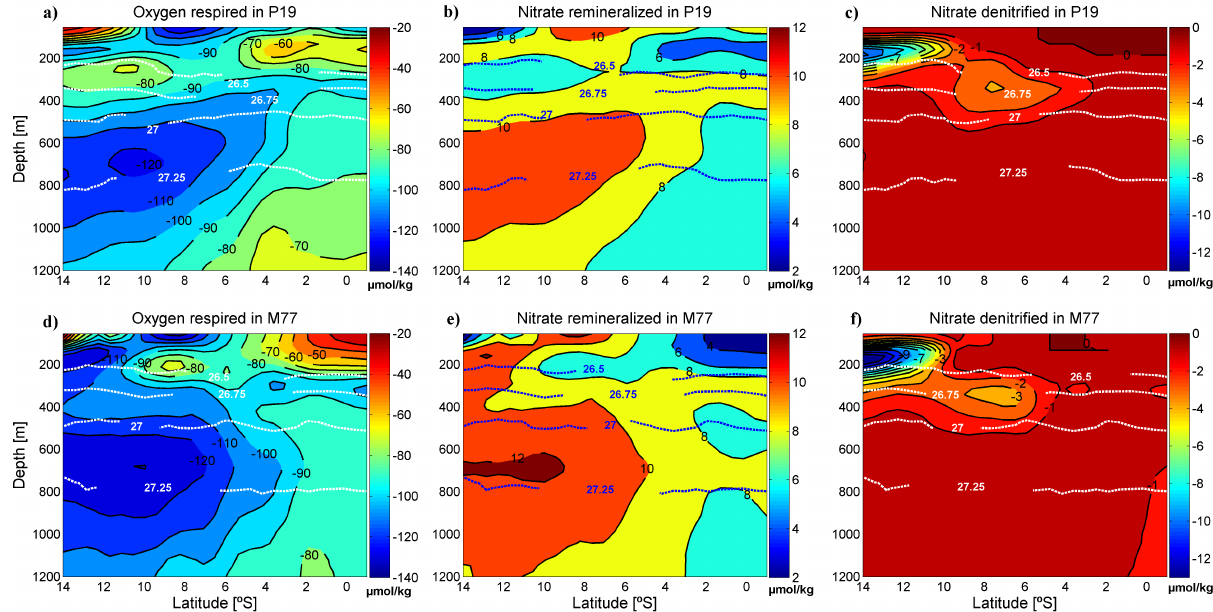
Fig. 6a. OMP-derived biogeochemical activity within the water column for the P19 (March 1993) and M77 (February 2009) cruises: (a) oxygen respired (µmolkg − 1 ) in P19, (b) nitrate remineralized (µmolkg − 1 ) in P19, (c) nitrate denitrified (µmolkg − 1 ) in P19, (d) oxygen respired (µmolkg − 1 ) in M77, (e) nitrate remineralized (µmolkg − 1 ) in M77, (f) nitrate denitrified (µ molkg − 1 ) in M77. Selected isopycnals are shown as dotted white/blue lines.